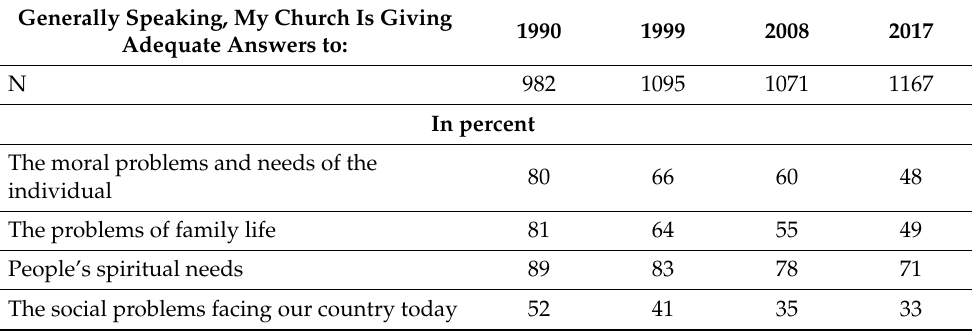
Table 2. Declared relationship to the Church in Poland (1990–2017) (in